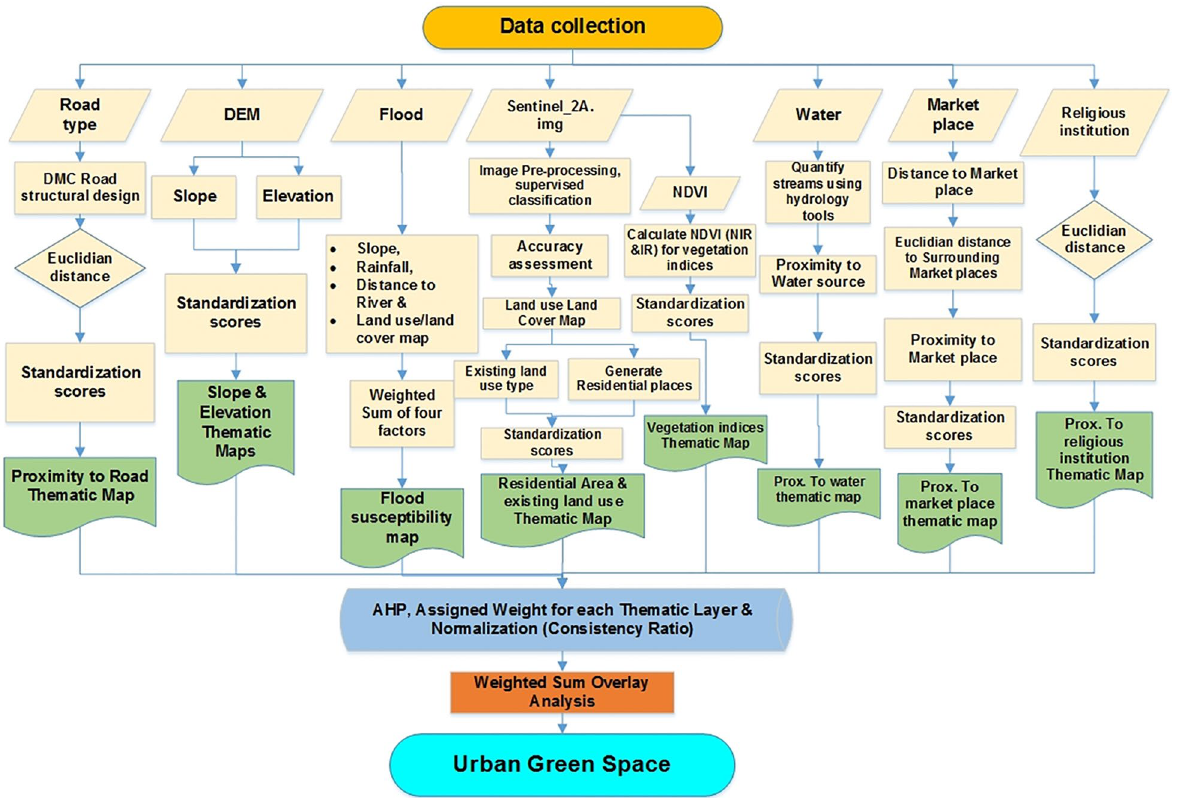
Fig. 2 Conceptual design of UGS in